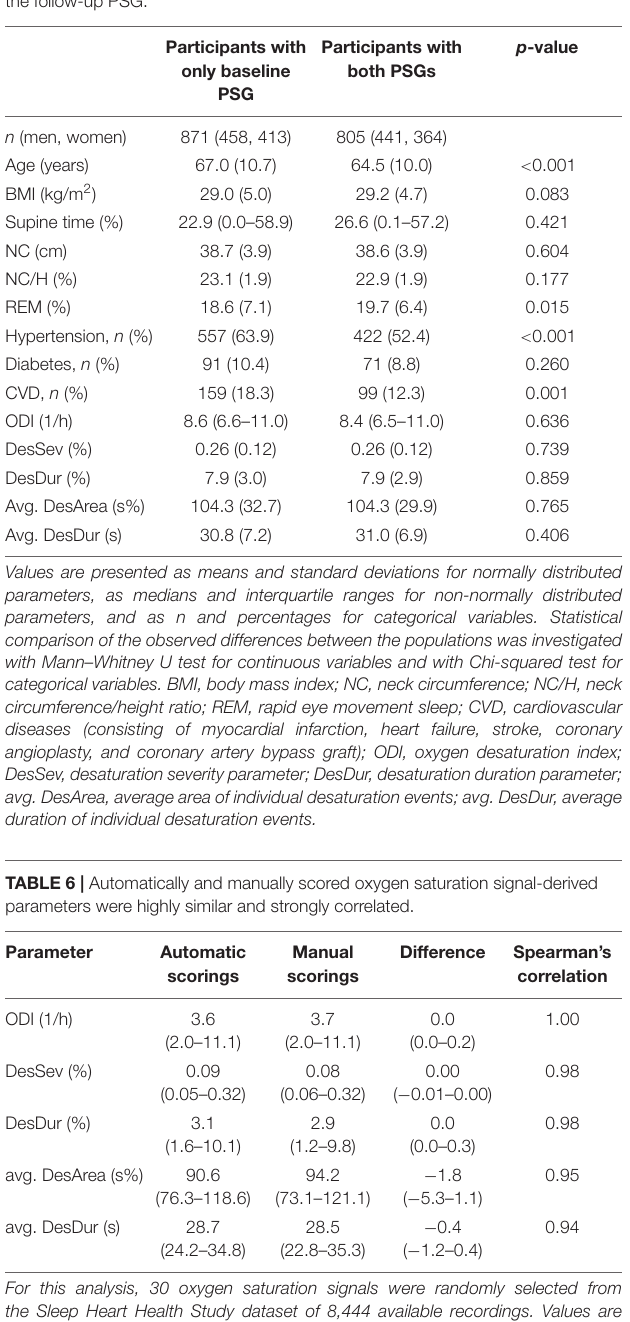
TABLE 5 | Comparison between participants with mild sleep apnea at baseline who participated only to the baseline PSG and those who participated also to the follow-up